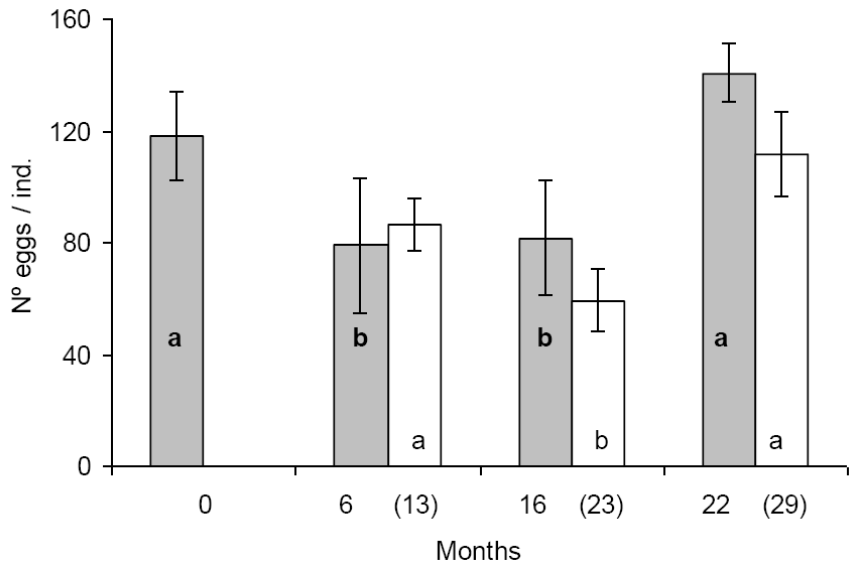
Figure 1. Average number of eggs per individuals (± SD) in F. candida populations fed continuously on Bt-maize for various numbers of months. Grey bars represent initial exposure (first set of experiments). White bars represent repeated exposure (second set of experiments). Different lower case letters in the same row indicate significant differences at p < 0.05. Bold lower case letters refers to grey bars, others to white ones. Number of months at the initial and repeated (in parenthesis) exposure are indicated on the